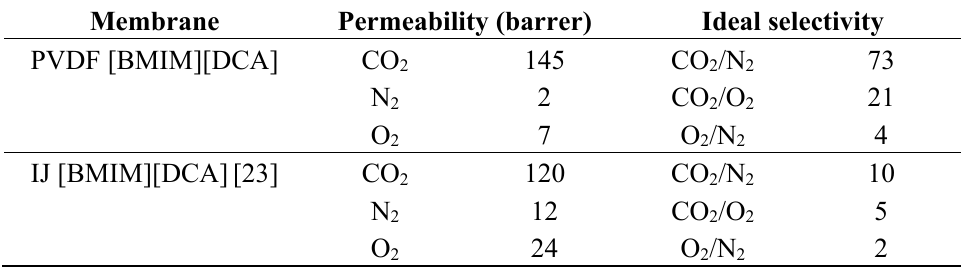
Table 1. Permeabilities of pure gases and calculated ideal selectivities, including results for an Ion-Jelly ® membrane from a previous work [23].